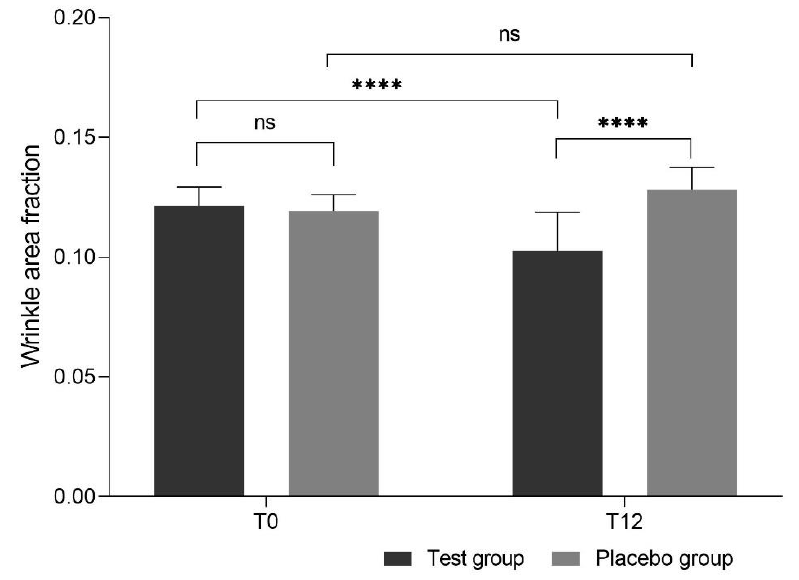
Figure 4. Wrinkle area fraction (mean ± standard deviation (SD)) before intake of study products (T0)